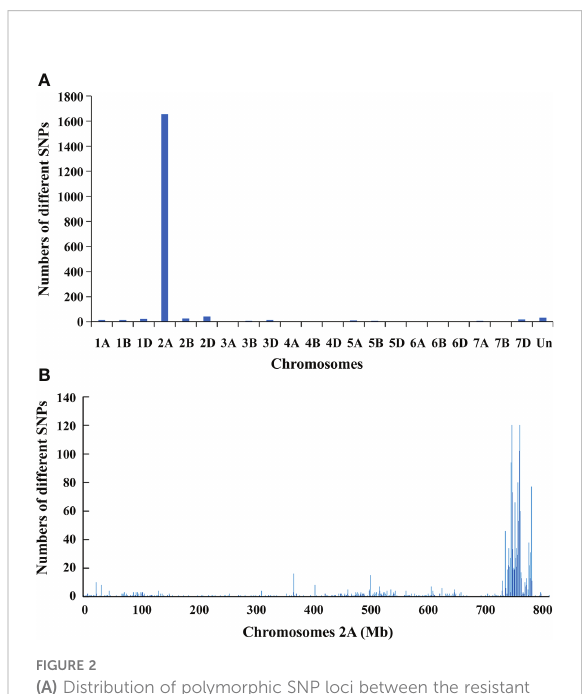
FIGURE 2 (A) Distribution of polymorphic SNP loci between the resistant and susceptible DNA bulks from the F 2:3 families of YAV249/ Shixin 828 on 21 chromosomes. (B) Density of polymorphism SNP loci on chromosome 2A with 1 Mb